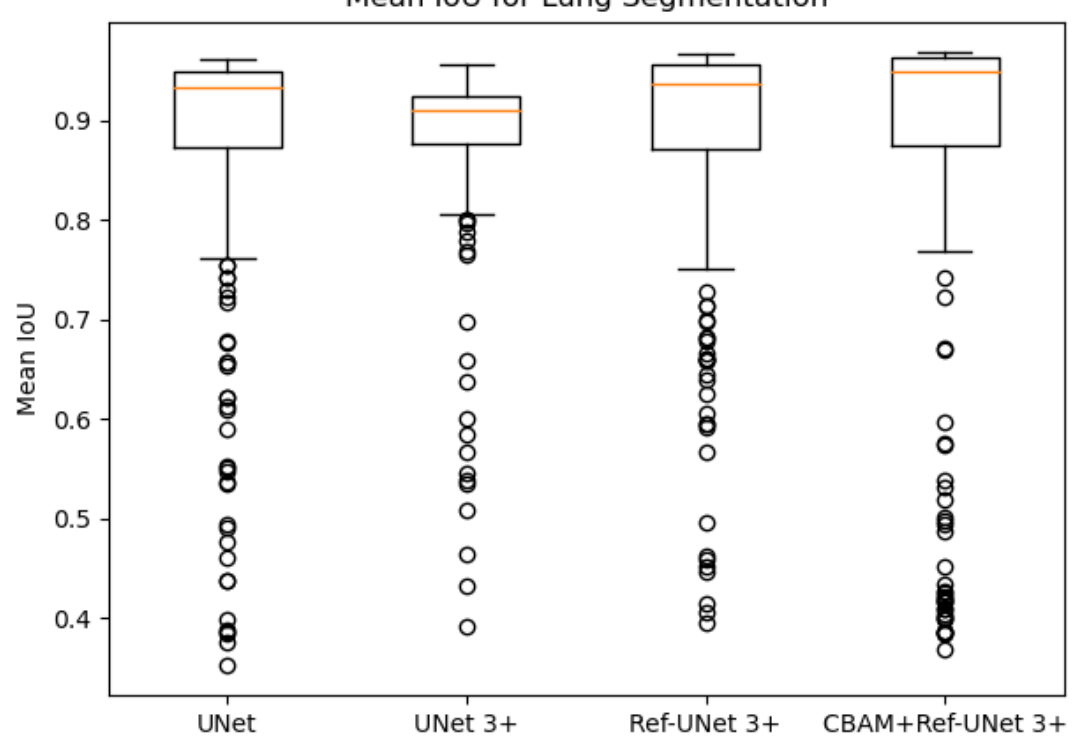
Figure 9. Mean IoU of the proposed models against UNet and UNet 3+.